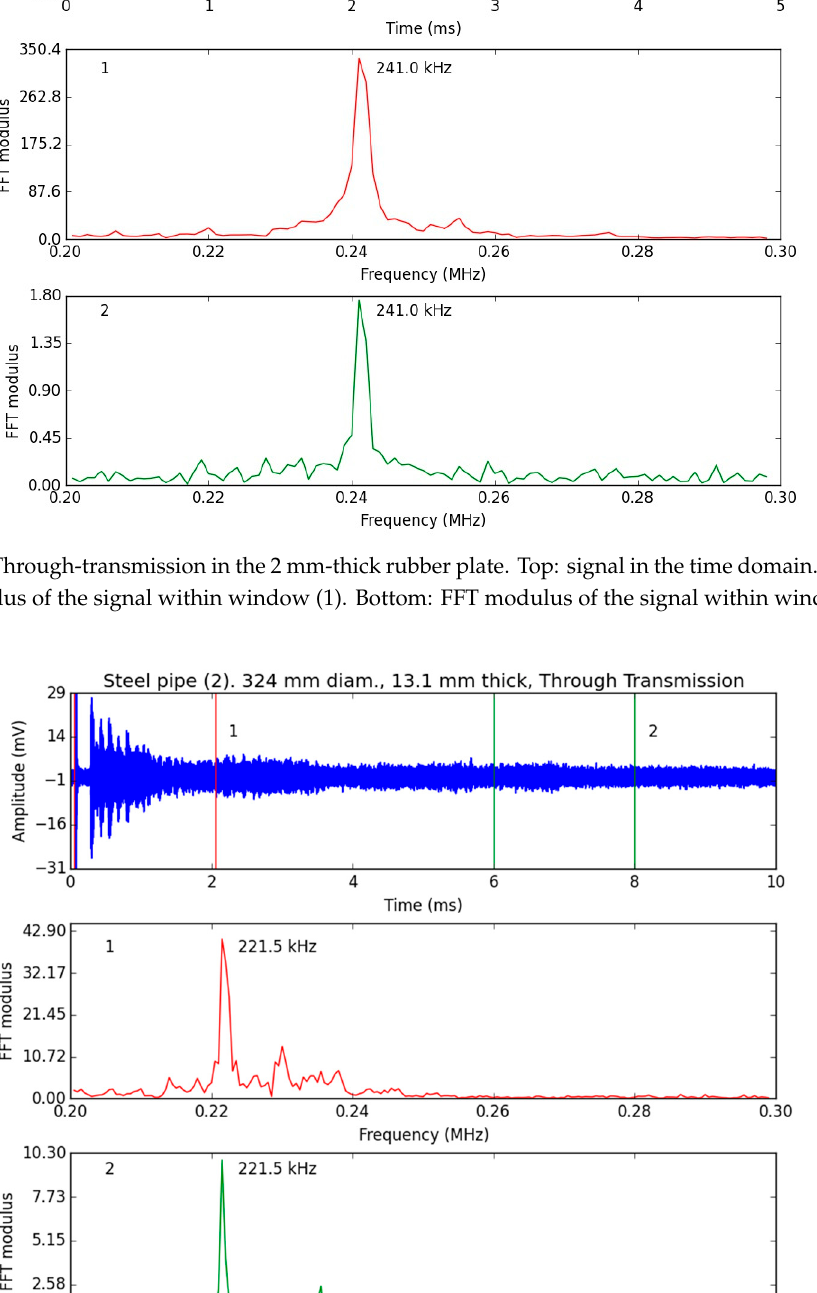
Figure 7. Through-transmission for the 324 mm diameter and 13.1 mm-thick steel pipe. Top: signal in the time domain. Center: FFT modulus of the signal within window (1). Bottom: FFT modulus of the signal within window (2).